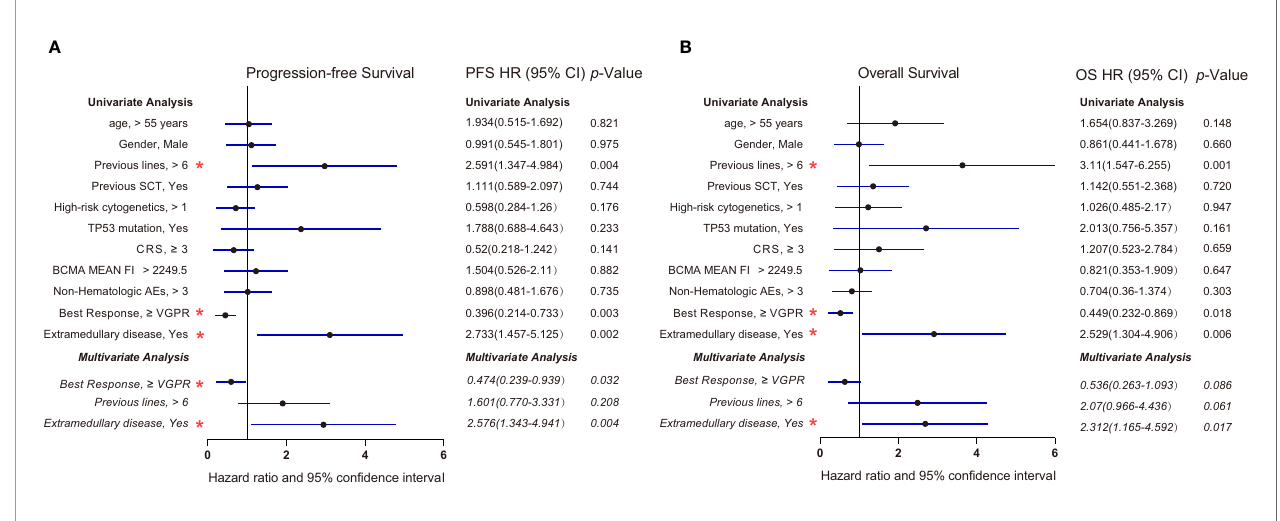
FIGURE 5 | Forest plots showing the association between risk factors and survival in our center (A) Progression-free survival (Cox regression, HR, and 95% CI). (B) Overall survival (Cox regression, HR, and 95% CI). Multivariate Cox regression analysis was performed by using the signi fi cant prognostic factors identi fi ed in univariate analysis. Multivariate analysis was indicated in italics. p values less than 0.05 (two-tailed) were considered statistically signi fi cant (highlighted with red “ * ” ). AEs, adverse events; CRS, cytokine release syndrome; HR, hazard ratio; MFI, Mean Fluorescence Intensity; SCT, stem cell transplantation; VGPR, very good partial